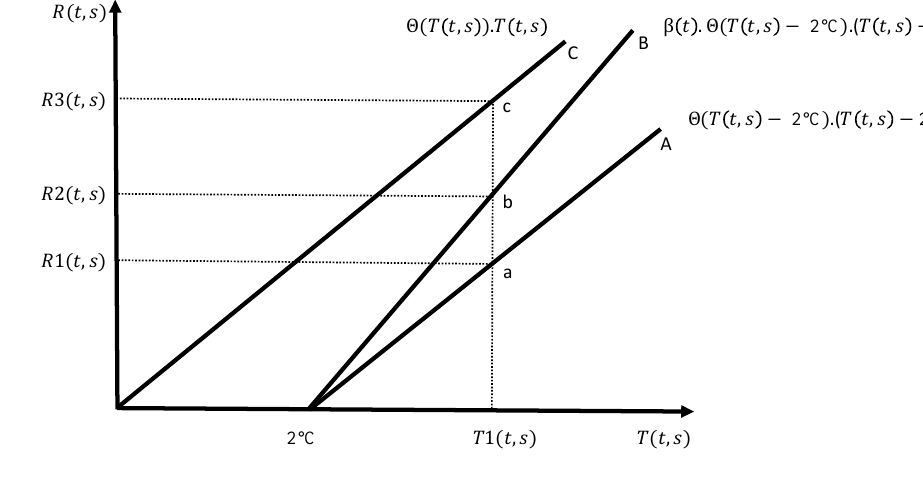
Figure 1. Risk function and the role of β ( t )